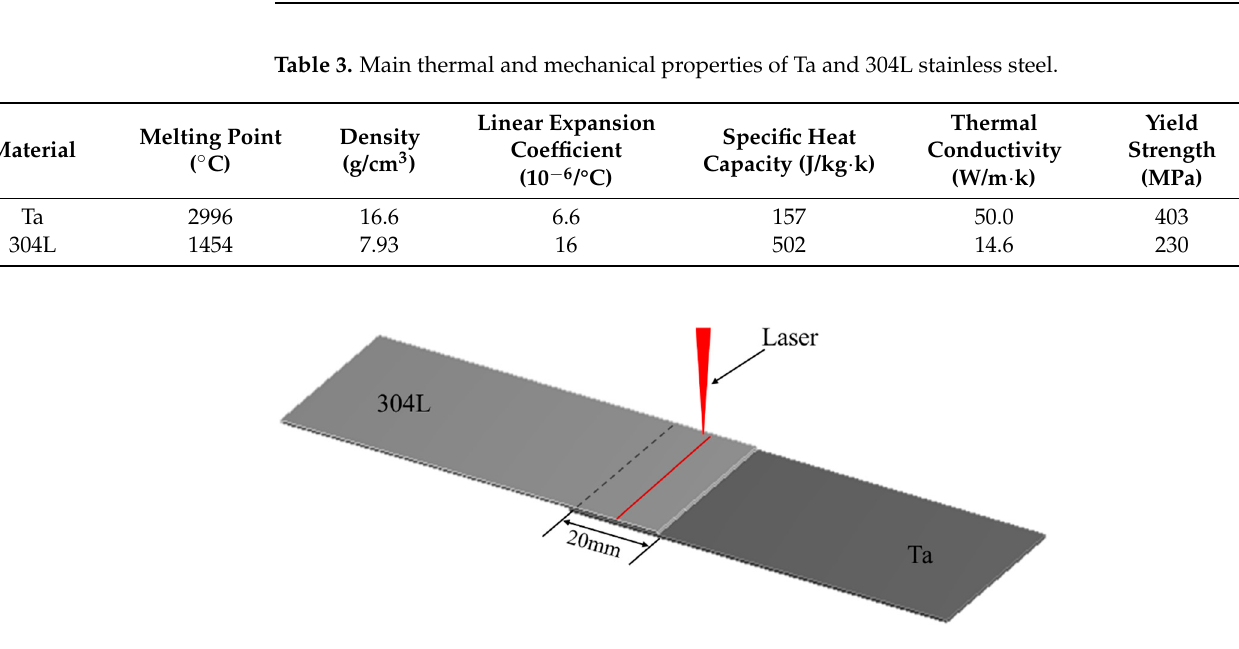
Table 2. 304L stainless steel chemical composition table (wt.).